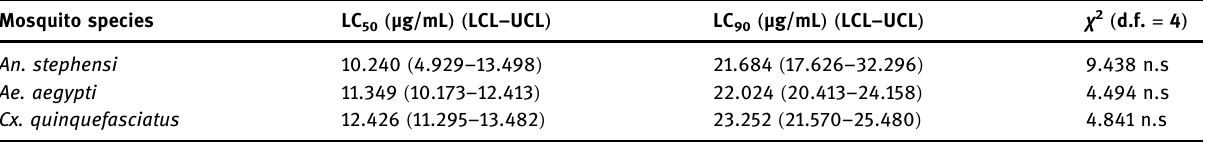
Table 2: Larval toxicity of Cs - AgNPs against An. stephensi, Ae. aegypti , and Cx. quinquefasciatus Mosquito species